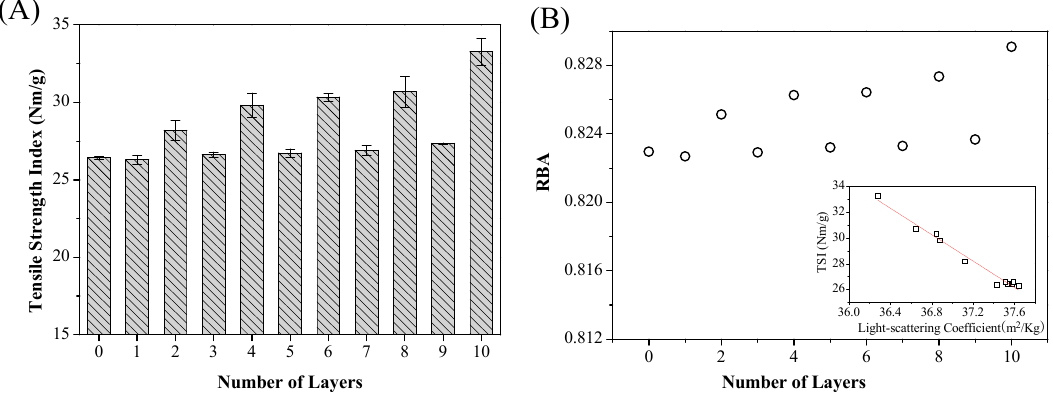
Figure 4. ( A ) Tensile strength index of different paper samples versus the layers number; and ( B ) the relative bonded area (RBA) of different paper samples versus the number of layers.